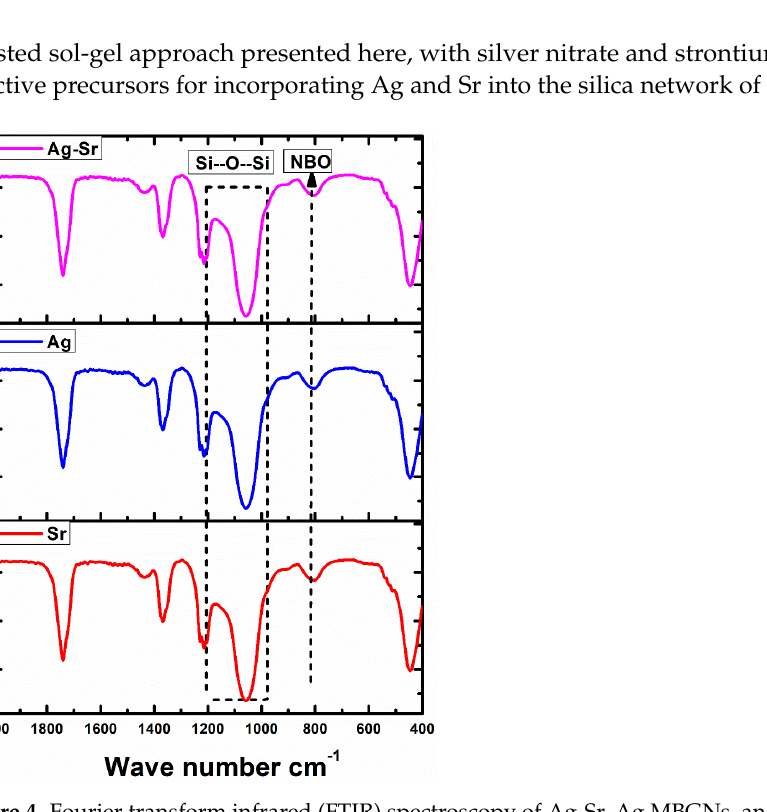
Figure 4. Fourier transform infrared (FTIR) spectroscopy of Ag-Sr, Ag MBGNs, and Sr MBGNs.